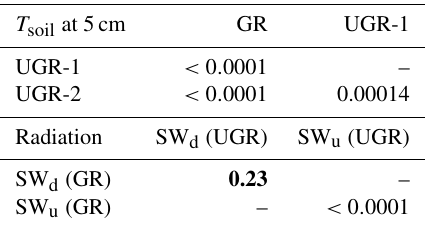
Table B2. Corrected p values (insignificant values marked bold) of pairwise t tests applied to daily means of T soil at 5cm, SW u (upwelling shortwave radiation) and SW d (downwelling shortwave